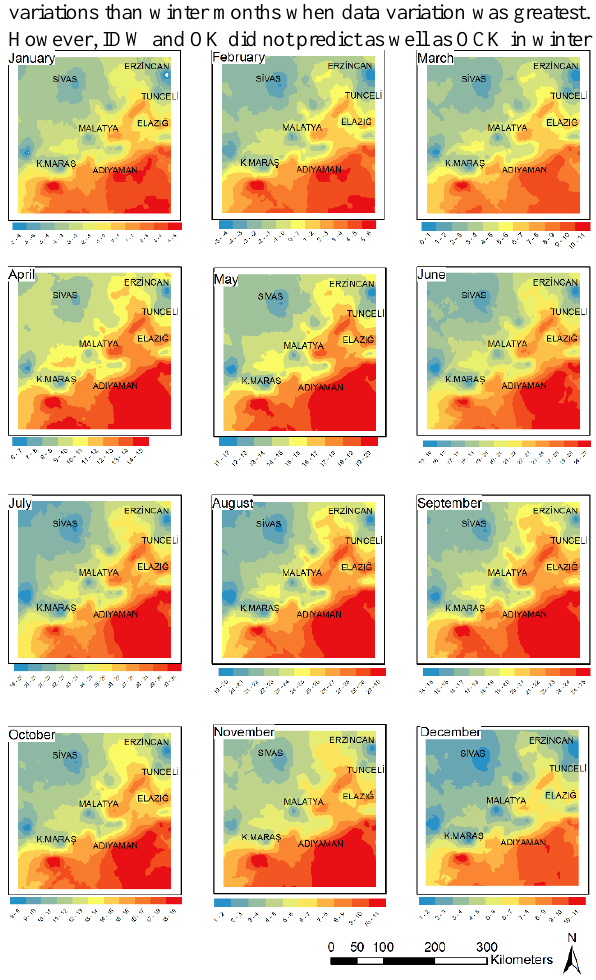
Figure 3. Mean monthly air temperature predict with